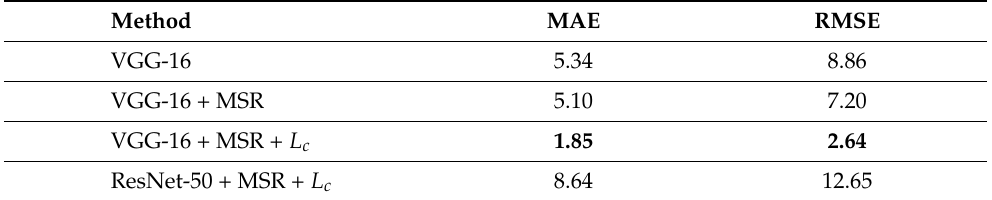
Table 4. Estimation errors for different components.